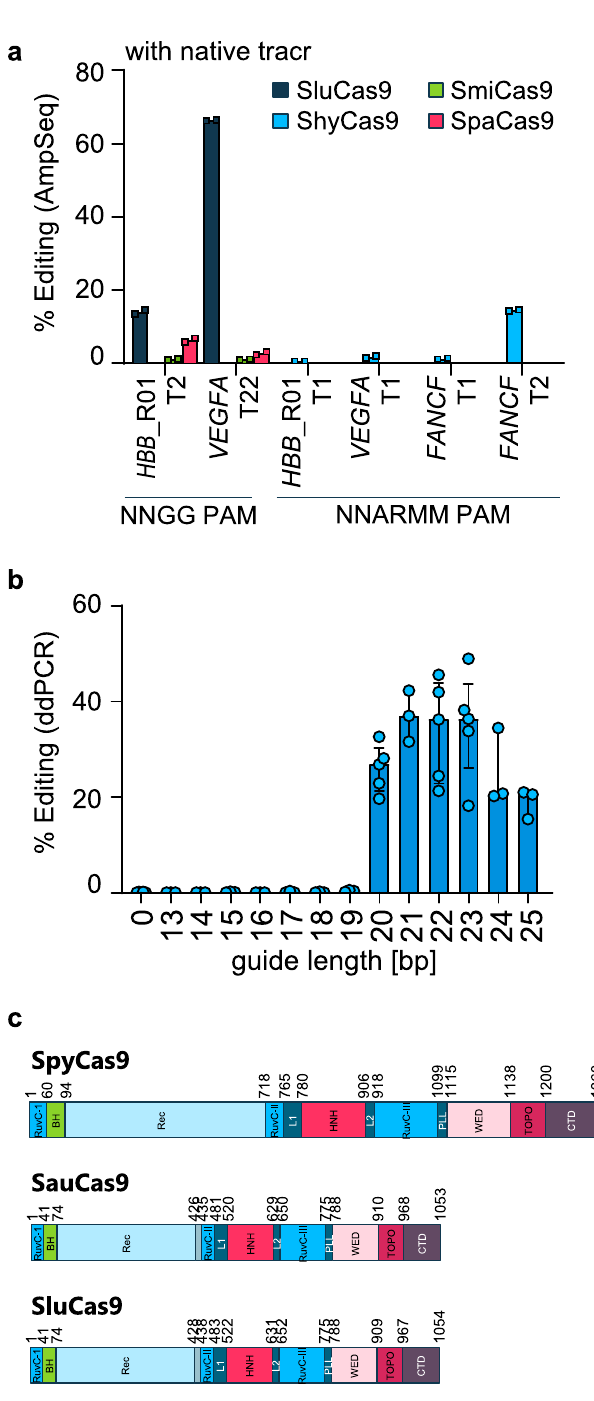
Fig. 1 Genome editing and domain architecture of four Staphylococcus Cas9s. a Activity of wild-type Cas9s on HEK293T loci assayed by